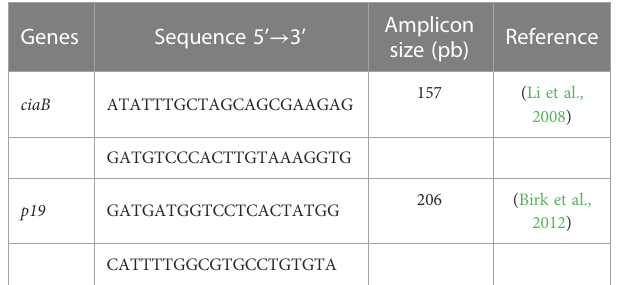
TABLE 1 Primers used to verify the production of transcripts for ciaB and p19 genes by Campylobacter jejuni in VT and VBNC.